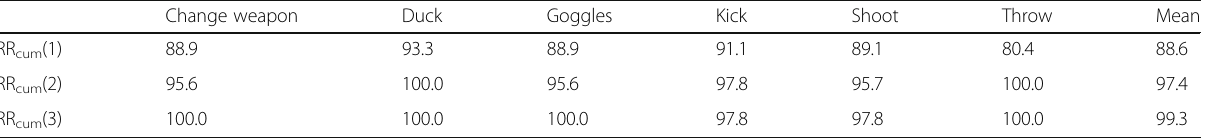
Table 6 Cumulative recognition rates for iconic gestures of MSRC-12 dataset Change weapon Duck